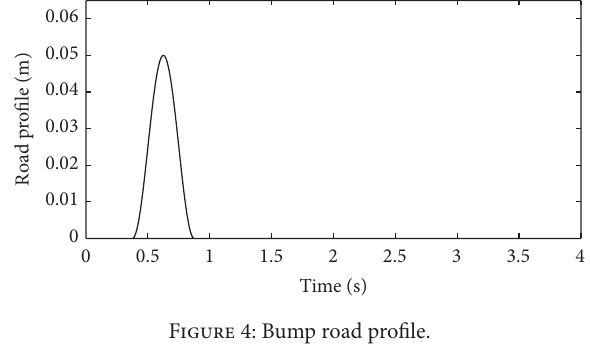
Figure 4: Bump road profile.